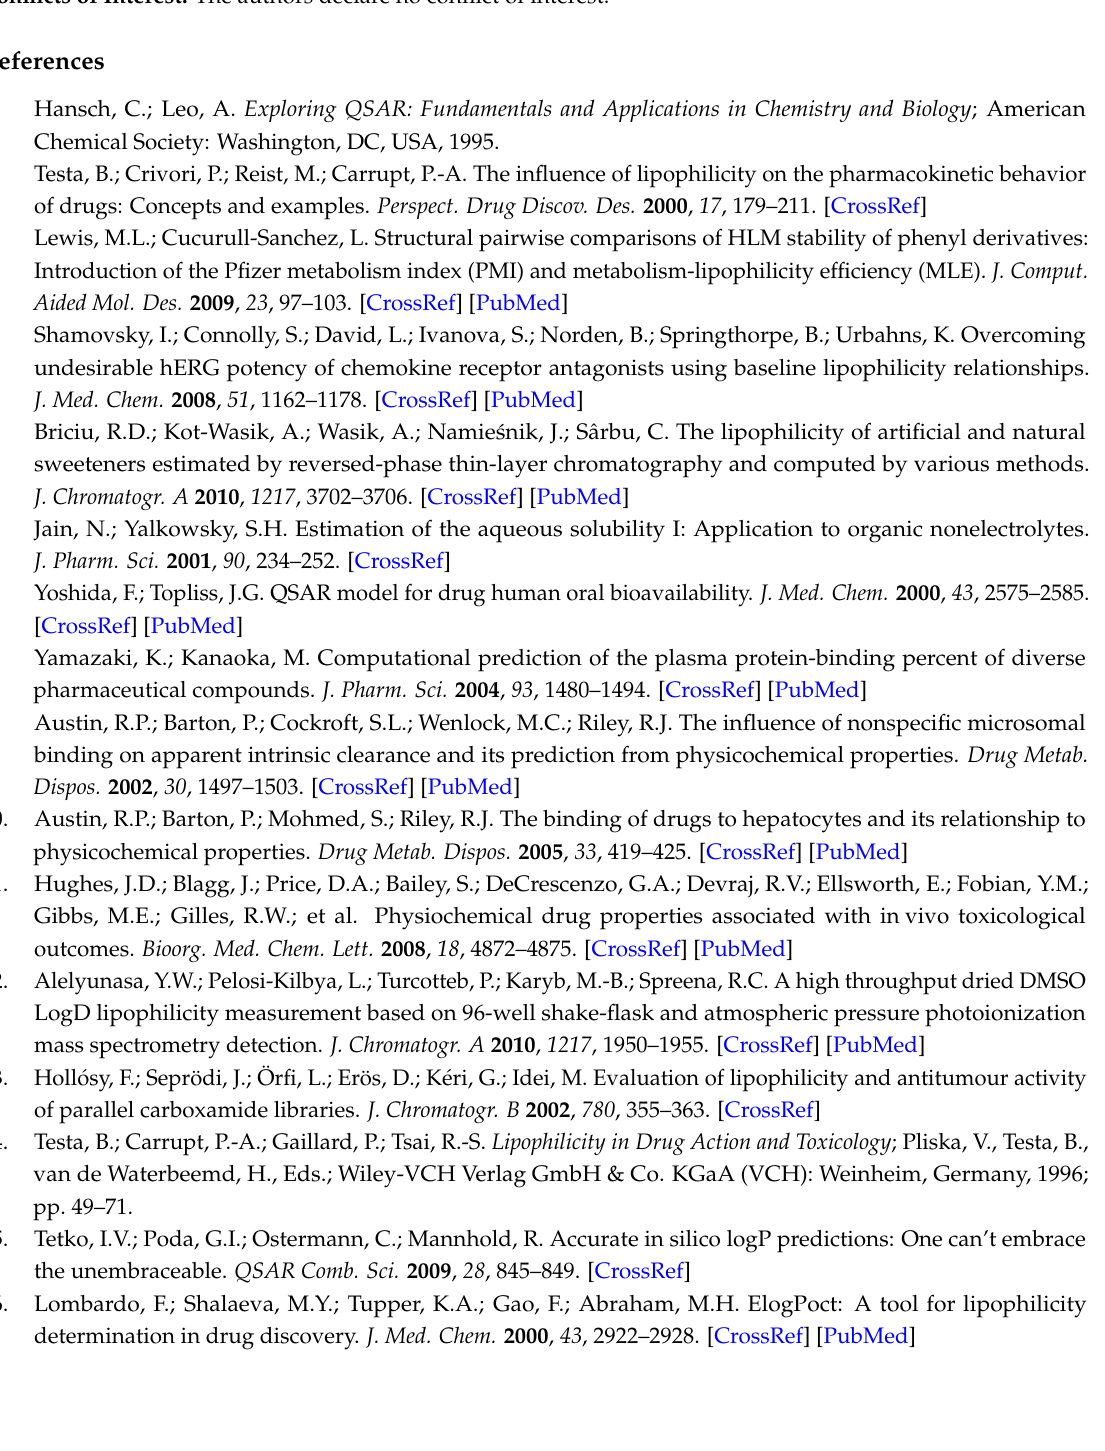
Supplementary Materials: Supplementary materials are available online. Table S1: The values of the retention time ( t r ) and logk for different concentrations of methanol in water (ranging from 45% to 75%) obtained on RP-18 column; Table S2: Statistics and parameters of Equation (1) obtained for standards with known logP